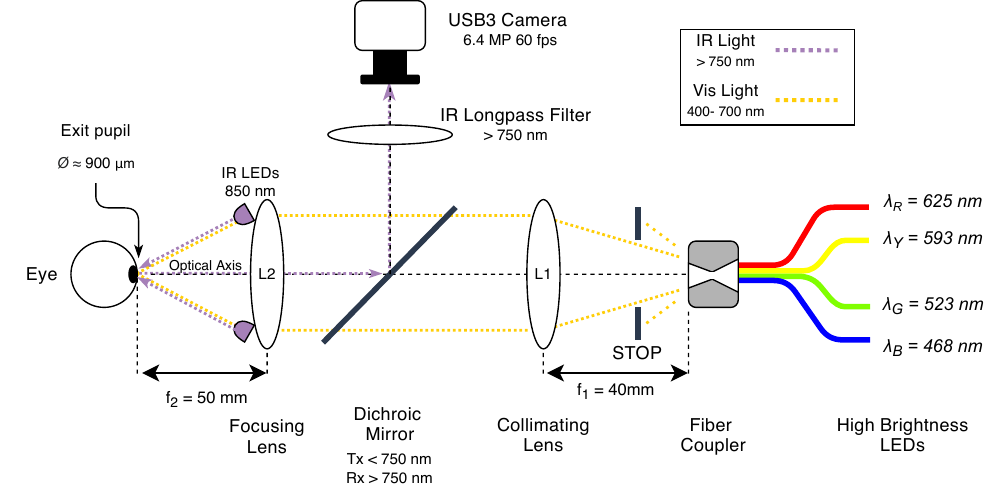
Figure 1. Optical diagram of the Pupillary Light Reflex instrument [21] used to collect data. The Infra-Red Light optical path (dashed purple line), i.e., the acquisition path , allows eye recording while eye stimulation is achieved through the Visible Light optical path (dashed yellow